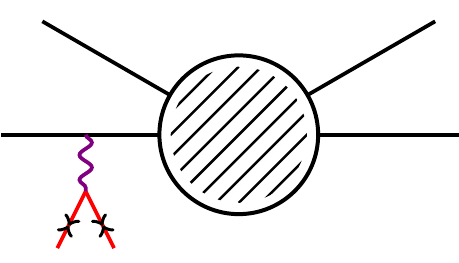
Figure 11 . Feynman diagram for double soft gravitini |